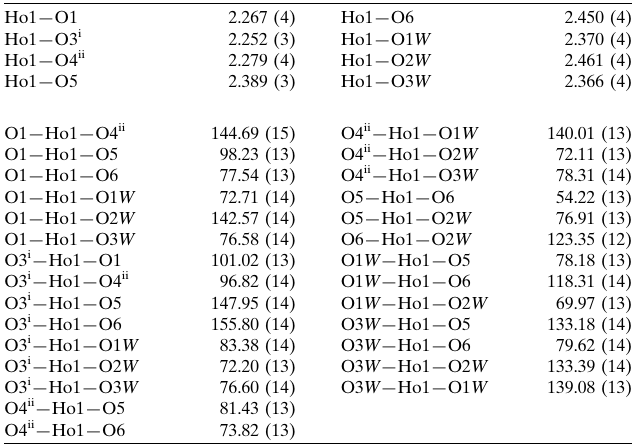
Selected geometric parameters (A˚ , (cid:3)